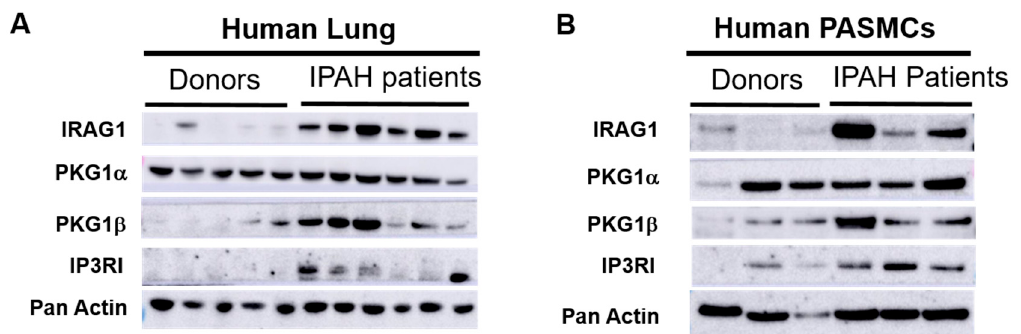
Figure 6. IRAG1 and PKGI β had stronger expression in lungs and isolated pulmonary artery smooth muscle cells (PASMCs) from end stage IPAH patients. ( A , B ) Western blots of protein lysates isolated from human lung homogenate ( A ) and human PASMCs ( B ). ( A ) 5 Donors and 6 IPAH patients lung samples were used. ( B ) 3 Donors and 3 IPAH patients PASMCs were used. Primary antibodies used in western blots were IRAG1, PKG1 α , PKG1 β , and IP3RI. Pan-actin was used as housekeeping gene.